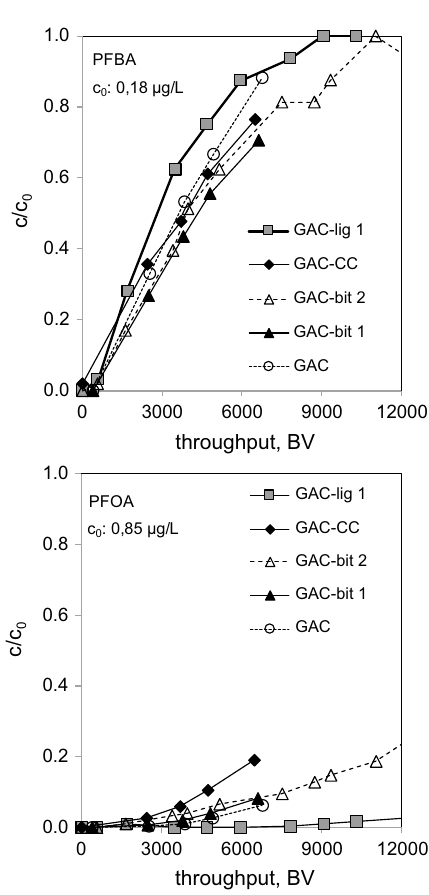
Fig. 4 Normalised breakthrough (c/c 0 ) of PFBA and PFOA during granular carbon selection test (GCS test) for different GAC